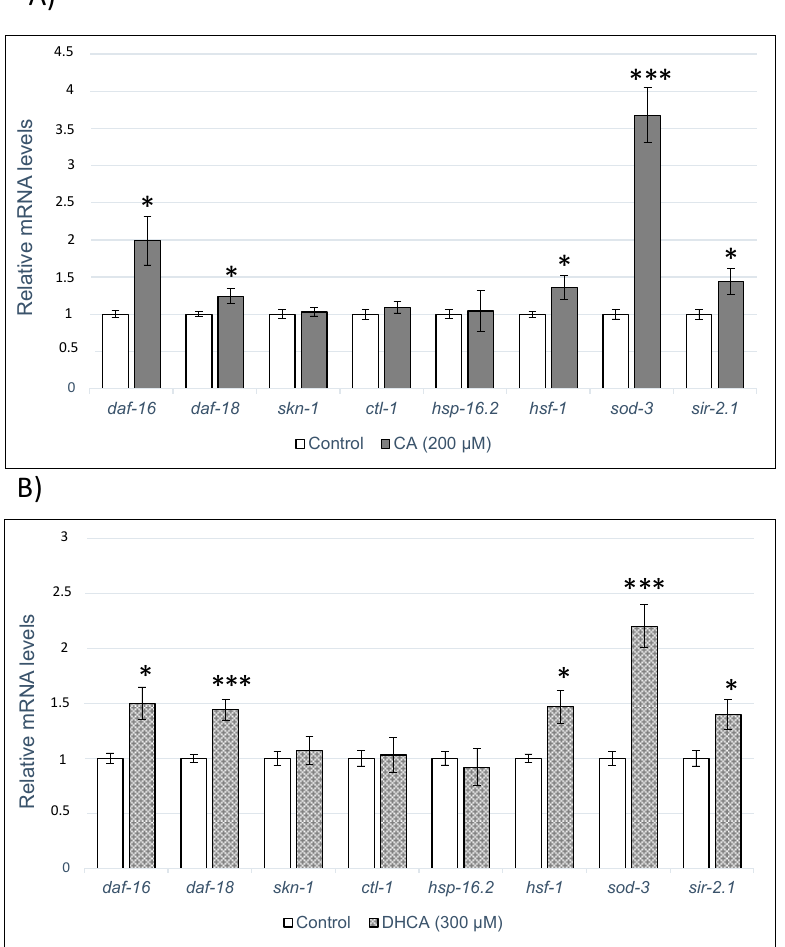
Figure 7. Expression of the genes daf-16, daf-18, skn-1, ctl-1, hsp-16.2, hsf-1, sod-3, and sir-2.1 in C. elegans cultivated in the absence (controls) and presence of ( A ) CA (200 M) or ( B ) DHCA (300 µ M). Analyses were carried out by RT-qPCR, using act-1 as internal control. Nine separate experiments were always conducted and the results represent the mean ± SEM. The statistical significance was calculated using ANOVA (* p < 0.05, ** p < 0.01, *** p < 0.001).